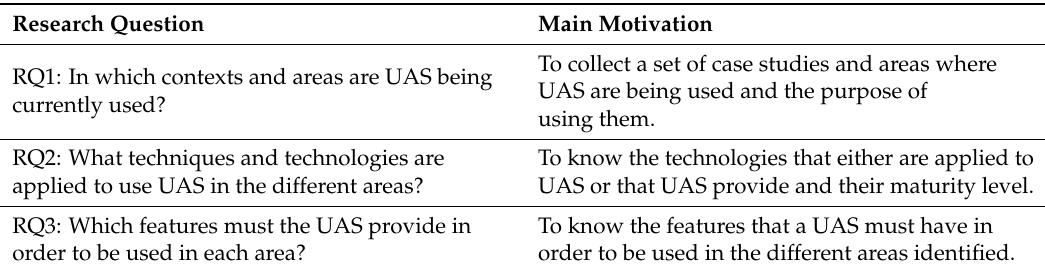
Table 1. Research